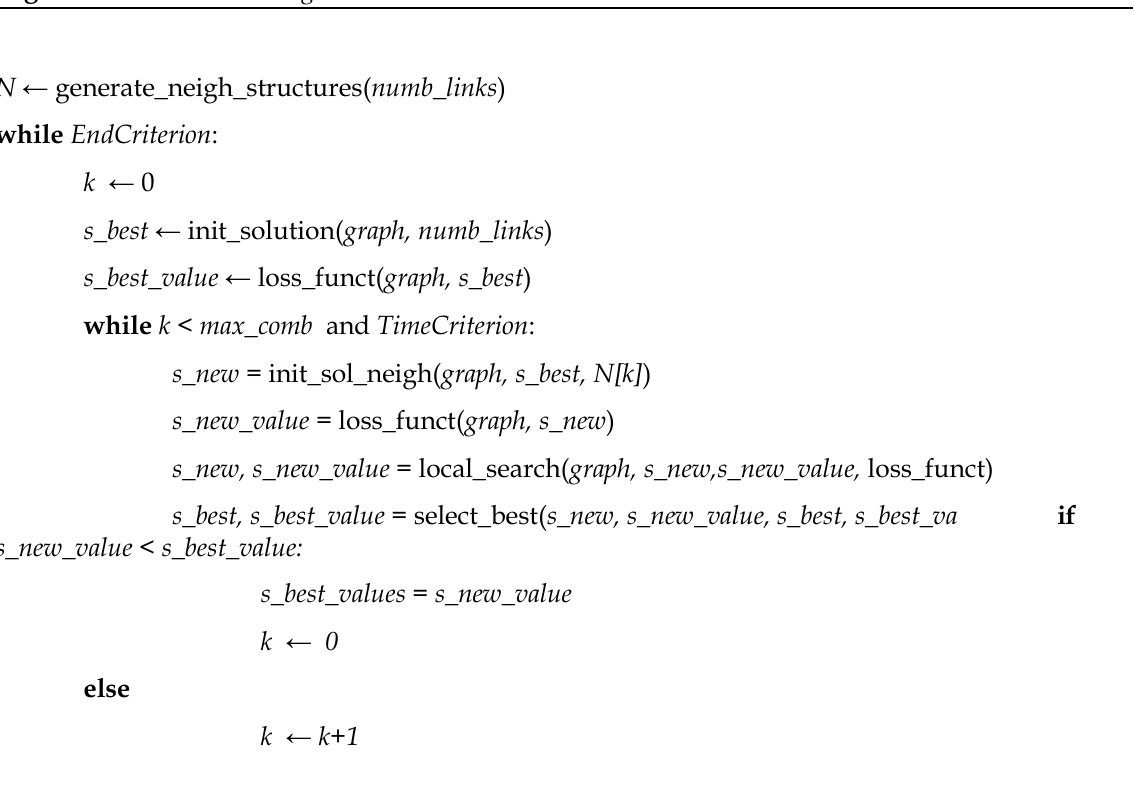
Algorithm A.4 Variable neighborhood